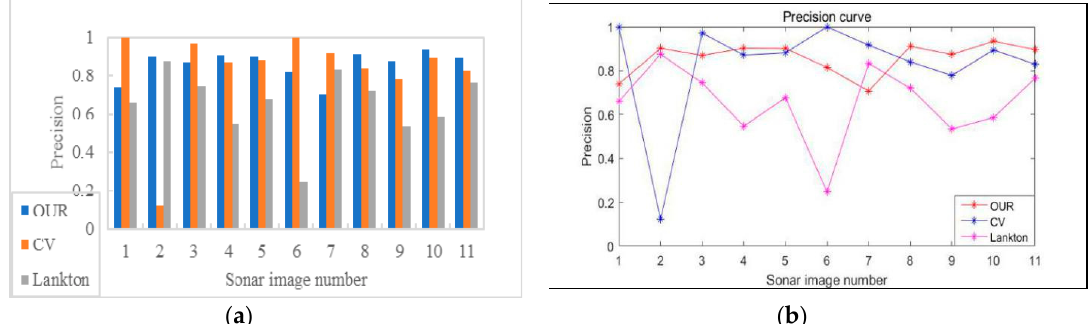
Figure 14. Precision curve. ( a ) Histogram of precision. ( b ) Line chart of precision.